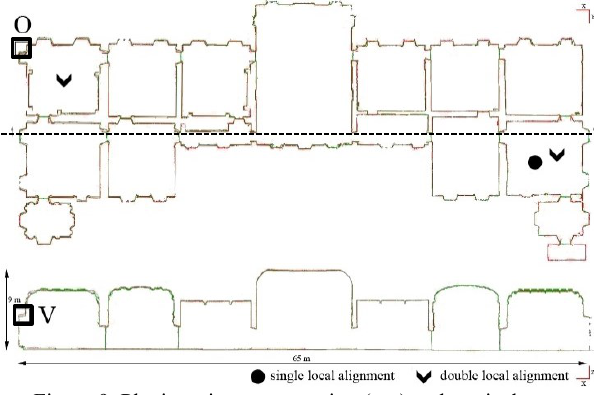
Figure 9. Planimetric representation (top) and vertical cut section (down), planimetrically positioned in dot line of the whole floor. Indication of the start/end point for the single local alignment (I) red, and the two fixing points for the double local alignment (III), blue.